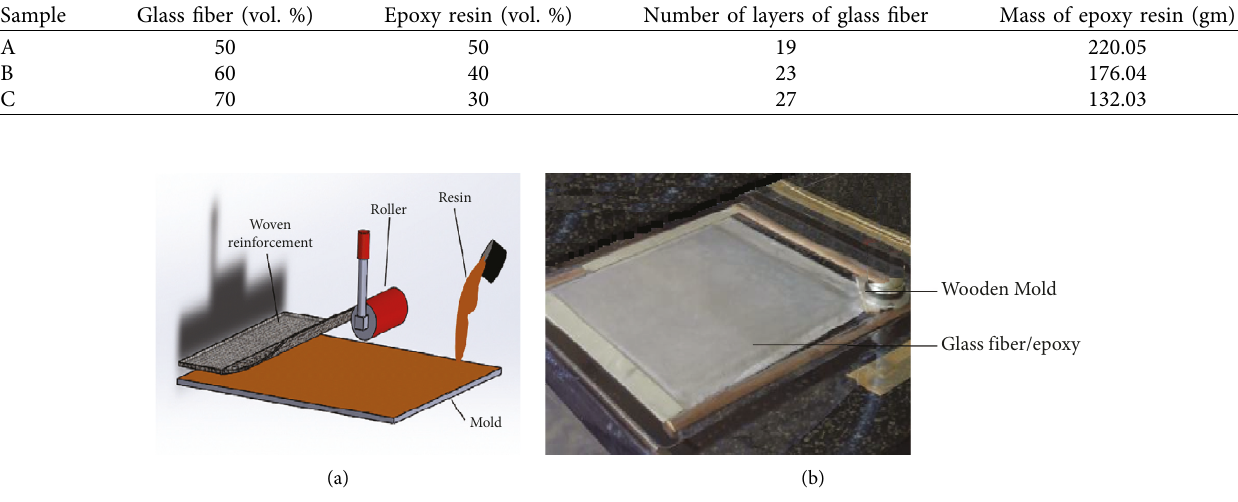
Figure 1: (a) Schematic of hand lay-up procedure. (b) Actual setup.